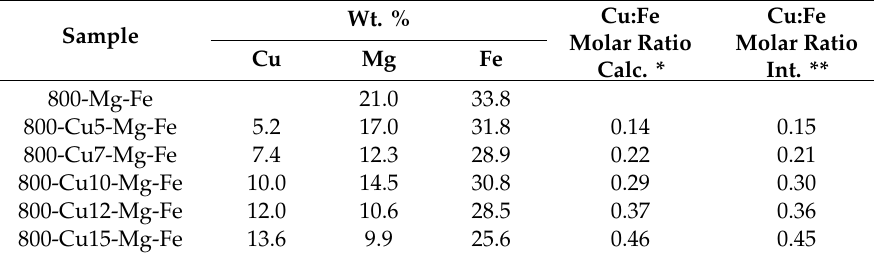
Table 3. Chemical composition of the 800-Cu-Mg-Fe-O catalysts.